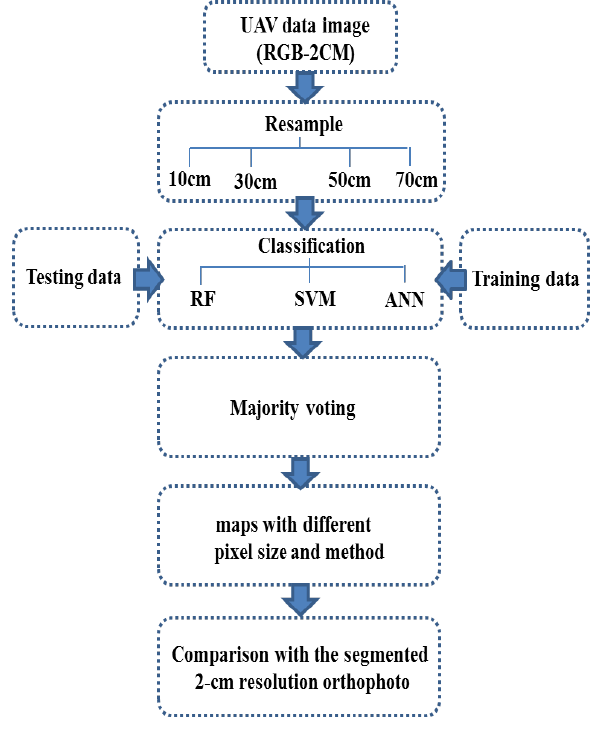
Figure 2. The flowchart of the